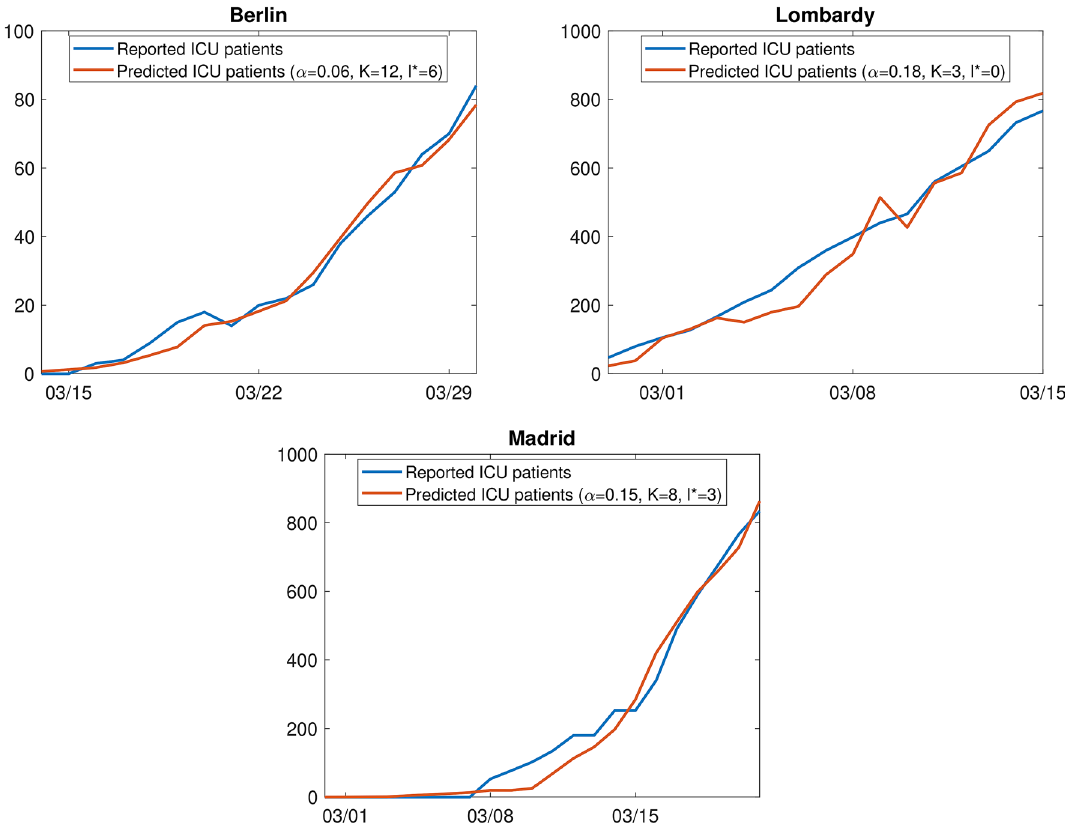
Figure 2. Best model fit for the number of ICU patients with ICU rate α , stay in ICU K and time lag l ∗ between positive testing and entering ICU, separately for Berlin, Lombardy, and